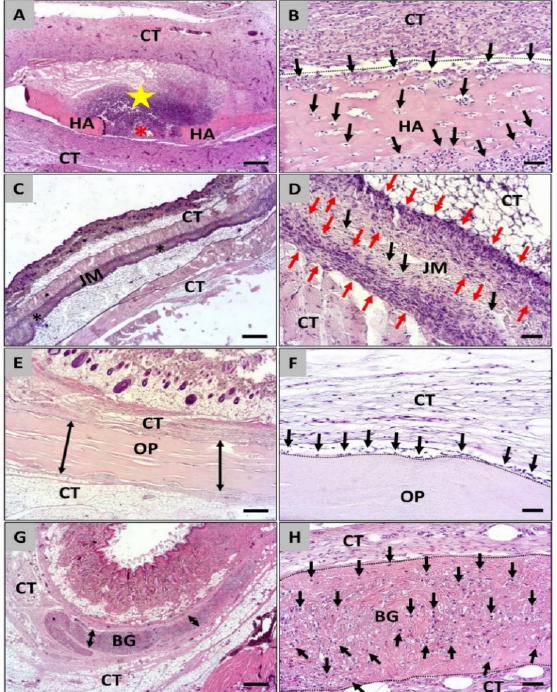
Figure 3. Histological images of the integration behavior and the tissue reactions of the four dif- ferent collagen membranes implanted into the subcutaneous connective tissue (CT) at day 30 post implantationem. Left column: All four membranes ( A , E , G = double arrows, C = asterisks) were detectable within their implantation beds and only the newly developed hyaluronan/collagen mem- brane (HA) showed signs of its fragmentation (red asterisk) associated with a granulation tissue with inflammatory cell infiltrate (yellow star). (H&E staining, 100 × magnifications, scalebar = 200 µ m). Right column ( B , D , F , H ): Also, at this time point varying cellular migration pattern (black) were observed starting from the material surfaces (dashed lines). HA = hyaluronan/collagen membrane, JM = Jason ® membrane, OP = Ossix ® Plus membrane, BG = Bio-Gide ® membrane, red arrows = cell wall within the collagen membrane (H&E staining, 200 × magnification, scalebar = 20 µ